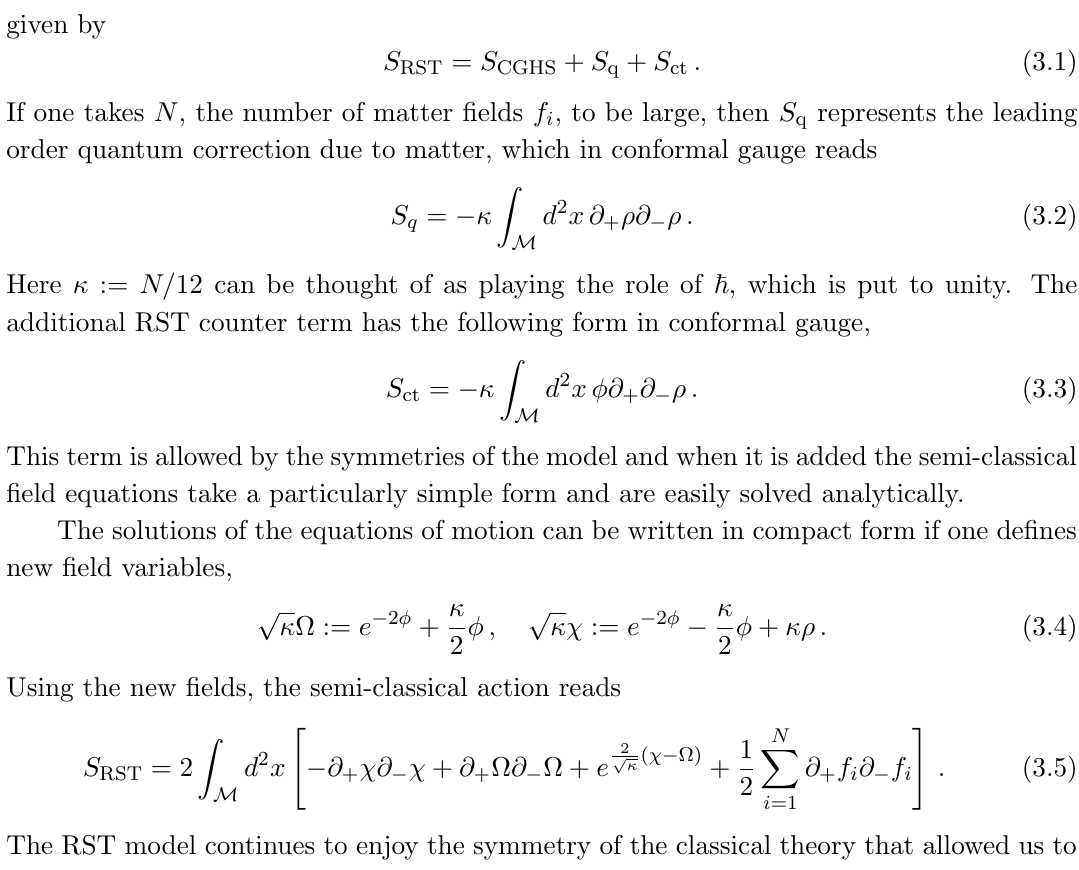
Figure 3 . This graph demonstrates the di(cid:11)erence between the volume growth V 0 starts growing at the time the shockwave crosses the anchor curve t 1 which is much earlier than the time t 2 the black hole is